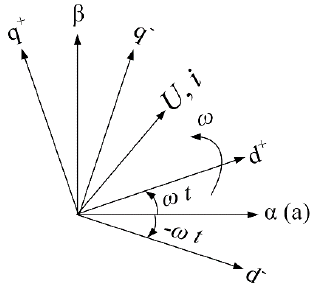
Figure 4. Diagram of the relationship between the stationary coordinate system and positive/negative synchronous rotating coordinate systems.